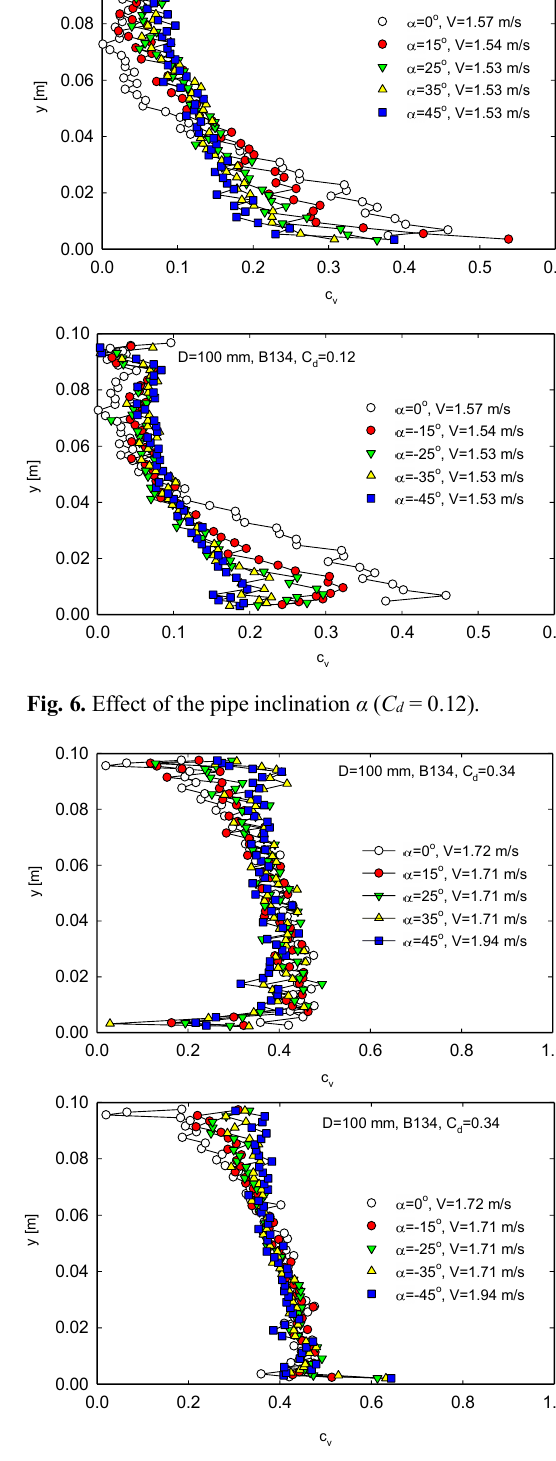
Fig. 7. Effect of the pipe inclination α ( C d =